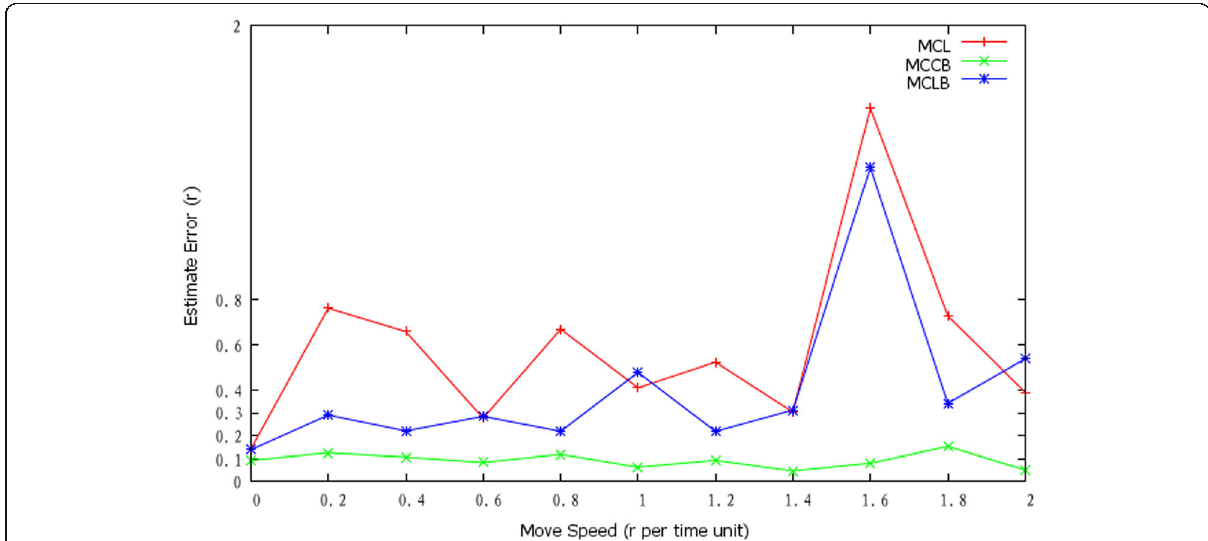
Fig. 7 Roadway width of 3 m comparison chart. For roadway width at 3 m under conditions, MCCB precision accuracy is still the best. It can be seen that coverage area is much larger than the width of the roadway, and with the roadway width becoming smaller, the positioning accuracy of the positioning method has all the mentioned precision at about